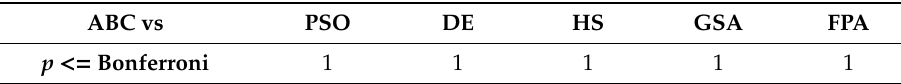
Table 9. Bonferroni correction for the case of ABC